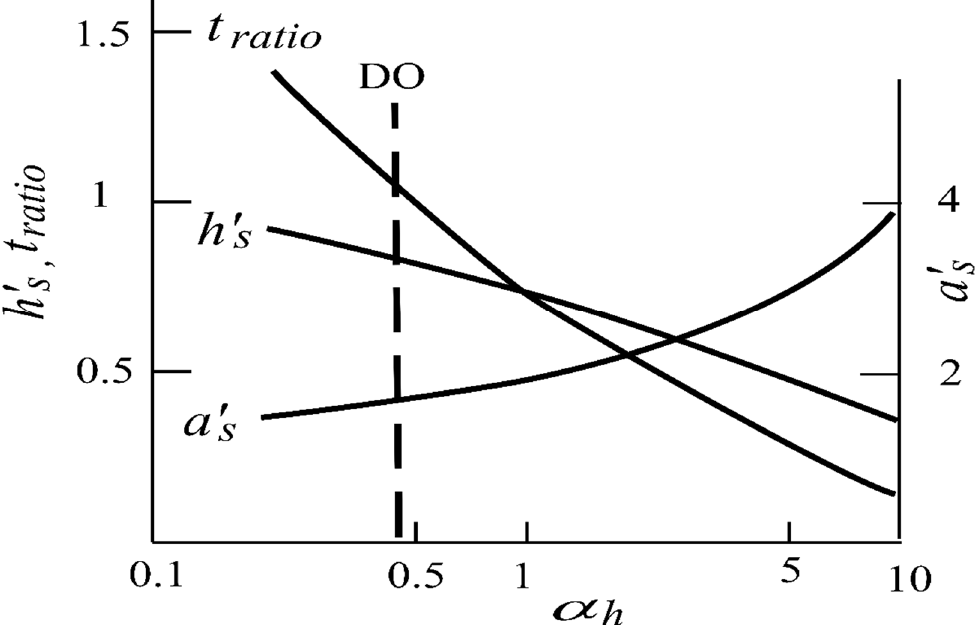
Figure 2. Ice-stream properties of the DO cycle plotted against the heating parameter. They are the termination height h (cid:48) s , the aspect ratio a (cid:48) s and the ratio of surge/creep durations t ratio . The vertical dashed line is representative of the DO cycle, which shows comparable surge/creep durations.